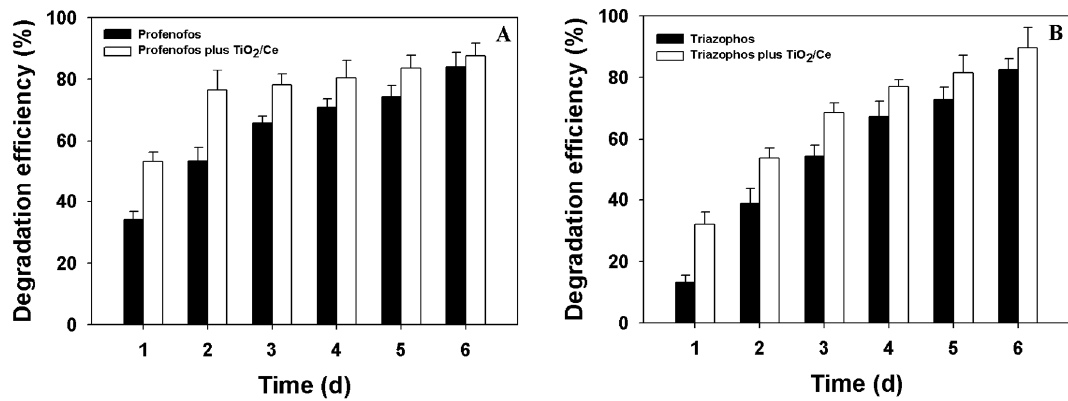
Figure 1. Degradation efficiency of profenofos and triazophos in B. chinensis . ( A ) profenofos; ( B ) triazophos.